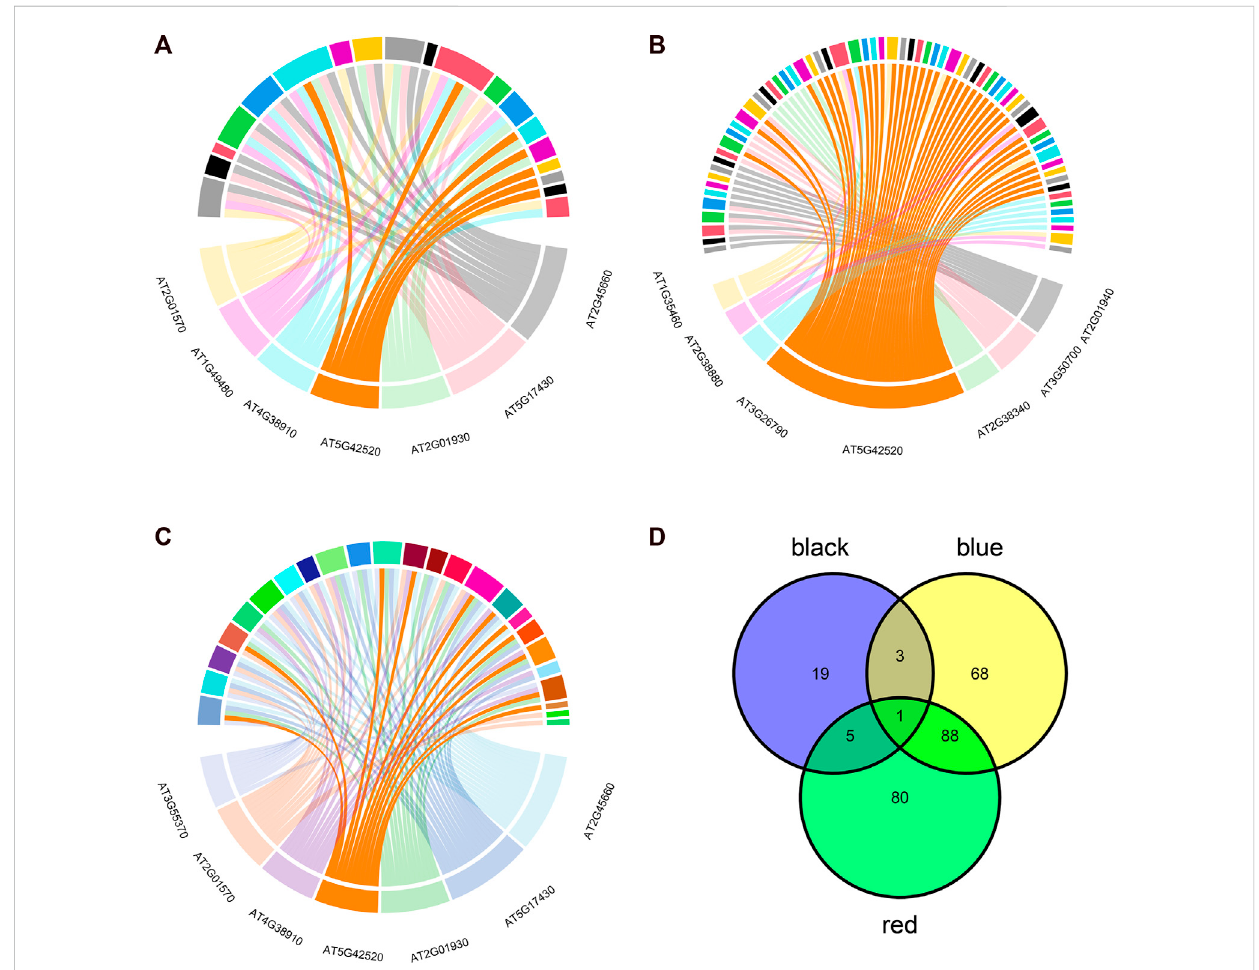
FIGURE 5 Transcription factor enrichment analysis results. (A) Transcription factor enrichment results of genes in the red module. (B) Transcription factor enrichment results of genes in the black module. (C) Transcription factor enrichment results of genes in the blue module. (D) Transcription factor enrichment results are